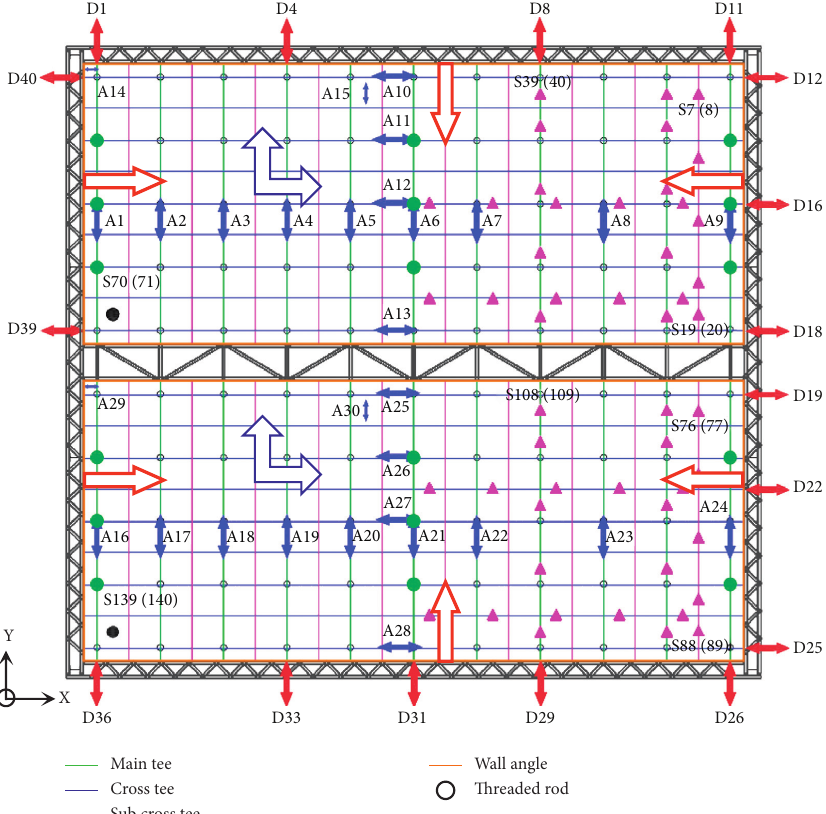
Figure 7: Instrumentation on the specimen. Notes: represents displacement transducer; represents accelerometer; represents strain gauge on the threaded rod; represents strain gauge on lay-in panel; and represents strain gauge on the main tee, cross tee, and sub cross tee.